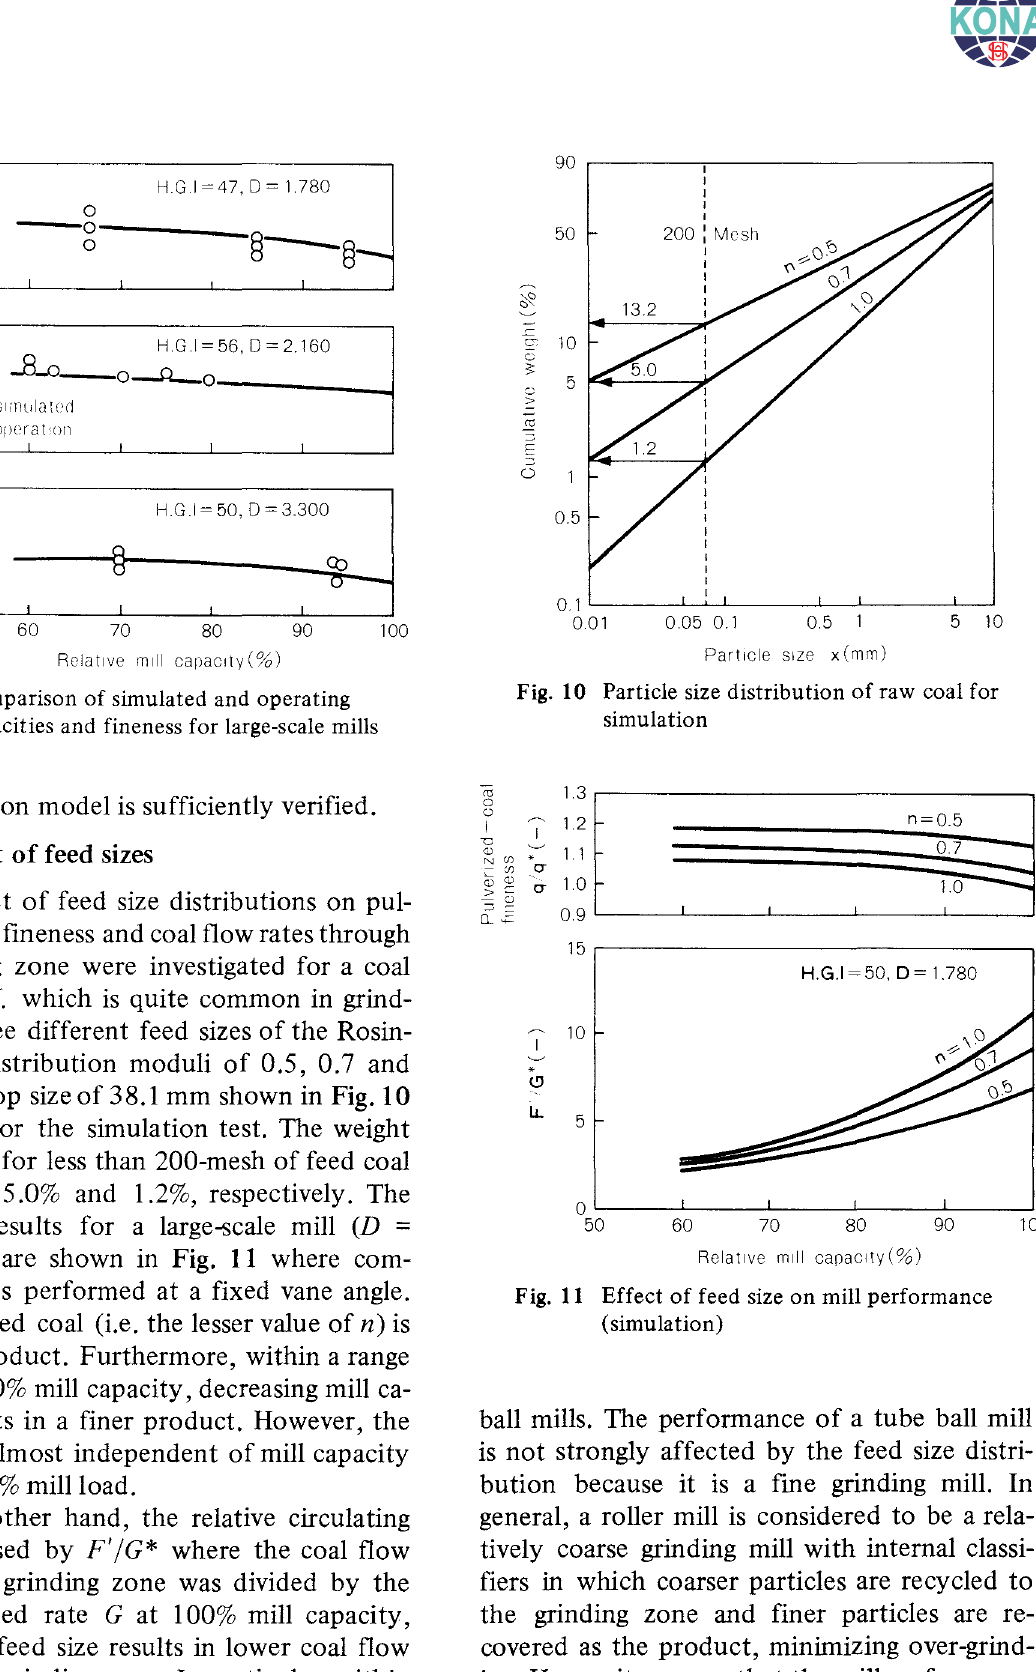
Fig. 10 Particle size distribution ofraw coal for simulation